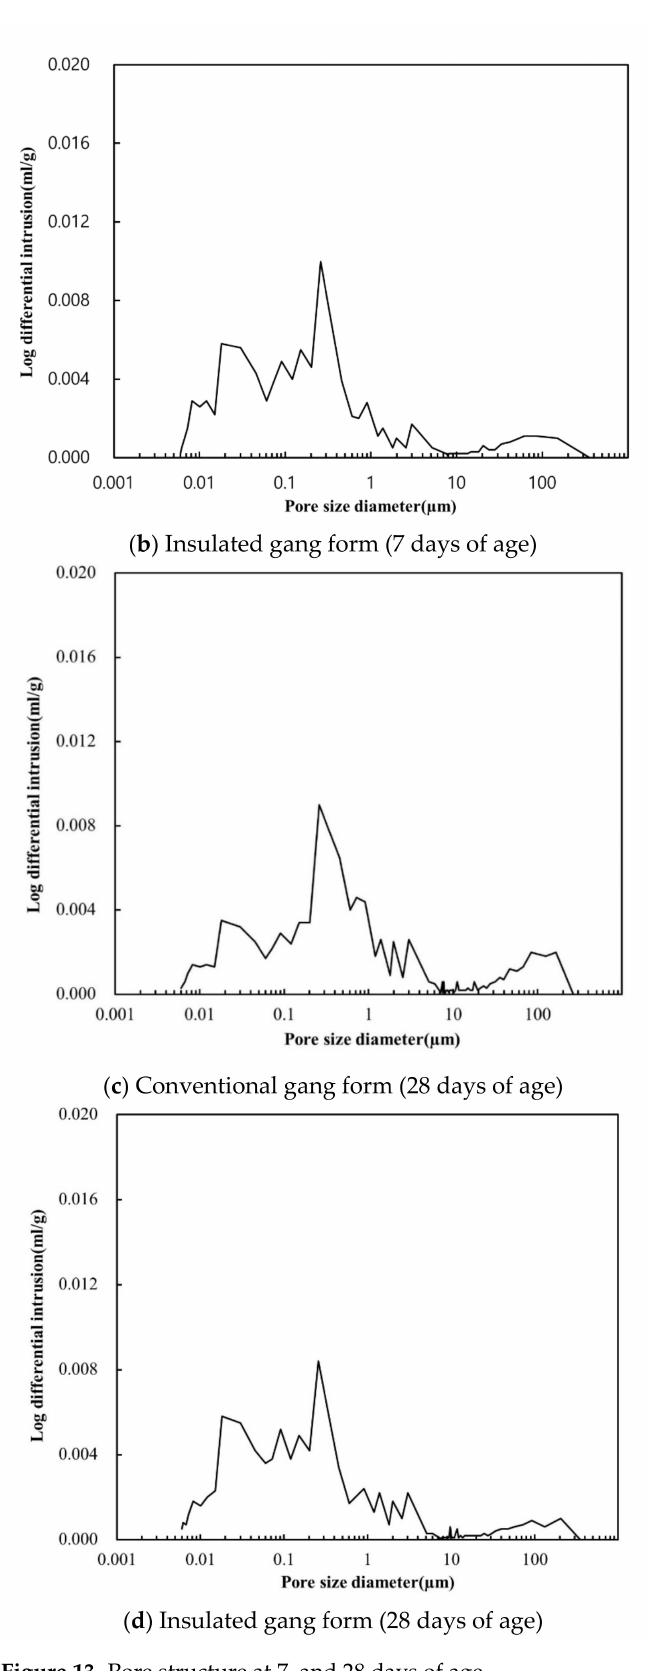
Figure 13. Pore structure at 7, and 28 days of